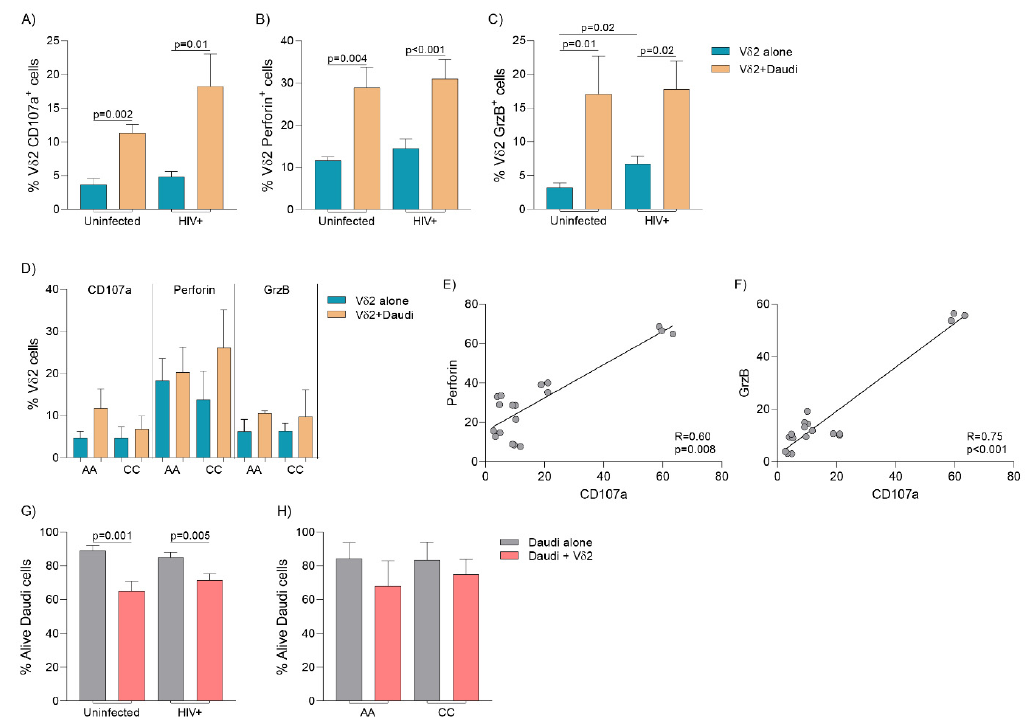
Figure 5. Cytolytic activity on expanded V δ 2 cells. Expanded V δ 2 cells were isolated and cocultured with Daudi cells (1:1 ratio) and degranulation and functional assays performed in uninfected donors ( n = 4) and PLWH ( n = 6). ( A ) Degranulation capacity was measured analyzing CD107a surface expression in isolated V δ 2 cells after expansion and upon coculture with Daudi cells. CD107a expression increased similarly in uninfected donors and PLWH ( p = 0.81, Mann Whitney U-test). ( B ) Expanded V δ 2 cell intracellular production of perforin increased upon coculture with Daudi cells and was comparable between uninfected donors and PLWH ( p = 0.97 and p = 0.60, respectively, Mann-